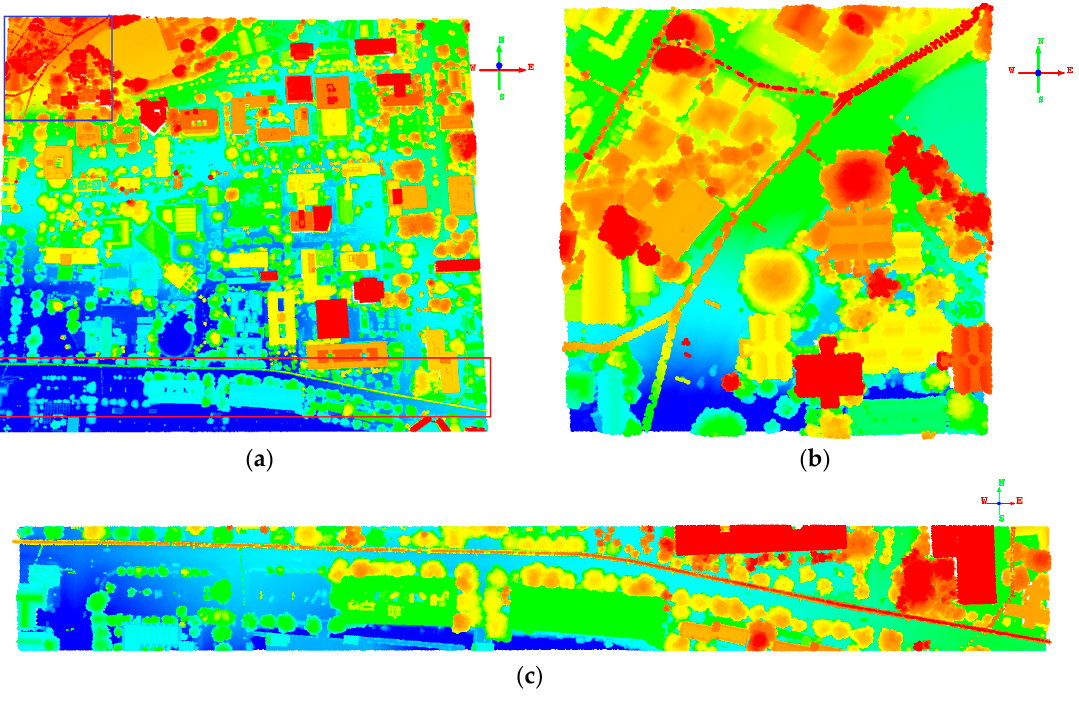
Figure 2. Visualization of the experimental datasets. ( a ) the whole large urban LiDAR scene around the campus of the University of Hawaii; ( b ) the UL (upper left area) Dataset from the blue rectangle in ( a ); ( c ) the LP (lower part area) Dataset from the red rectangle in ( a ). The linear objects of red to orange points are power lines. Table 1. Number of labelled 3D points in the two